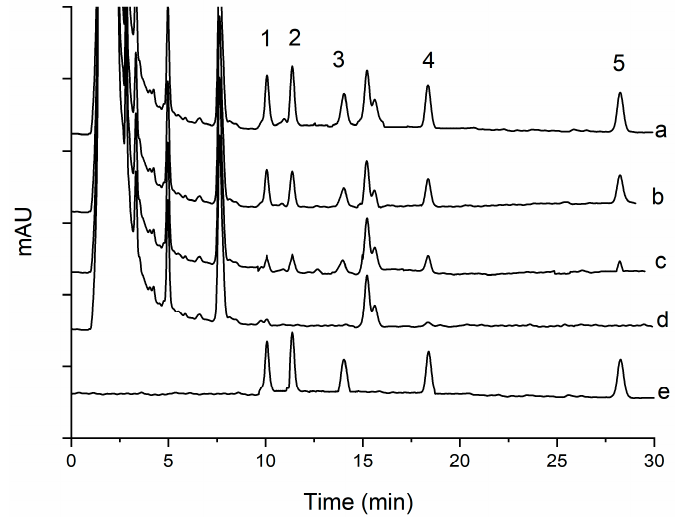
Figure 5. Typical chromatograms of five pyrethroids in oral qutanling liquids under optimum conditions: (1) transfluthrin, (2) fenpropathrin, (3) fenvalerate, (4) etofenprox, and (5) silafluofen. In chromatograms (a, c, d), the spiked levels are 100, 20, and 0 ng mL − 1 , and (b, e) show the standard solution in blank matrix and acetonitrile.